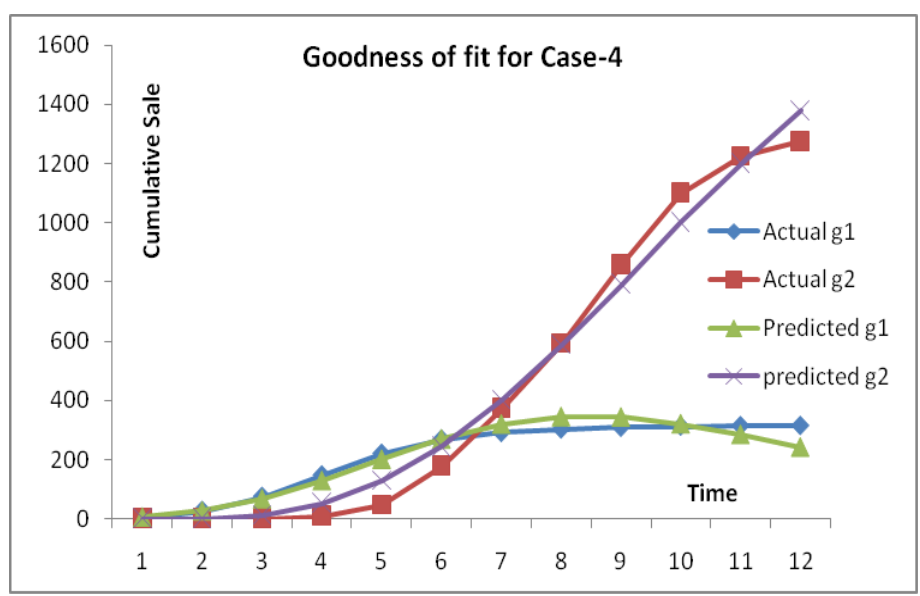
Fig. 4. Goodness of fit curve for